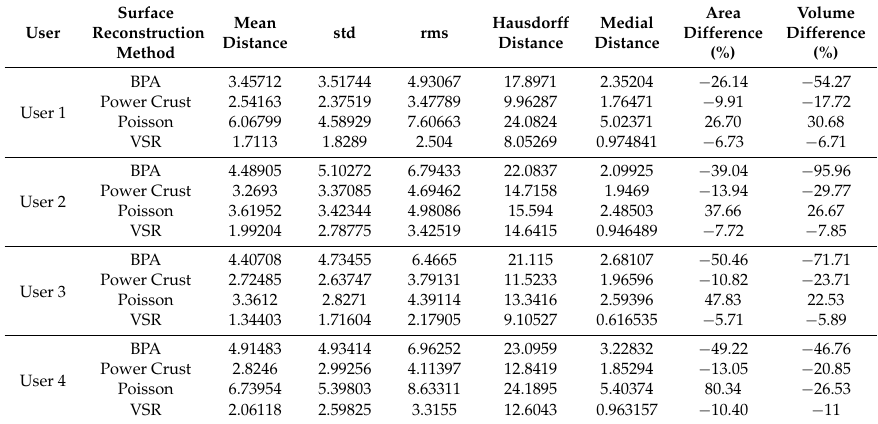
Table 3. Difference between the reconstructed surface and the original surface (HUMAN KIDNEY; the contours were drawn by different users).